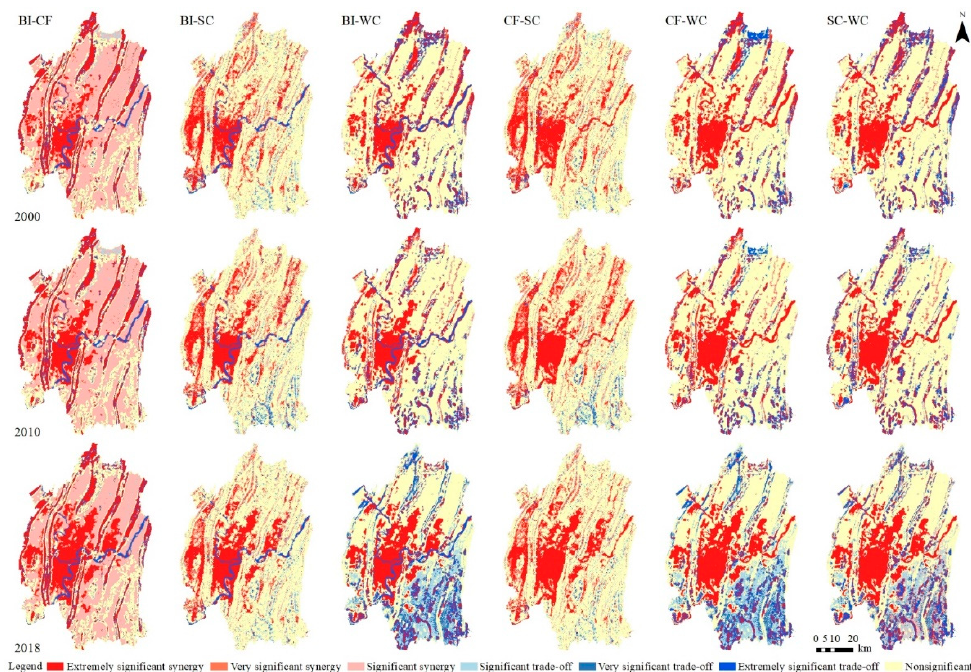
Figure 8. Spatial trade-offs and synergies between ES pairs.